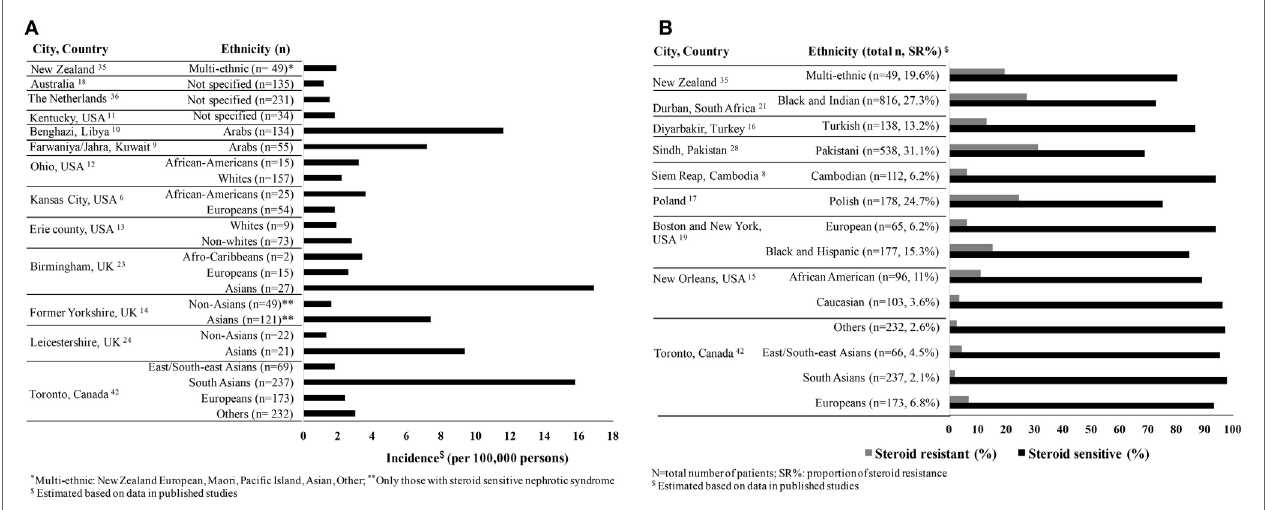
FiGURe 1 | (A) Incidence of childhood nephrotic syndrome per 100,000 persons by ethnicity reported from 1946 to 2014. (B) Variability of steroid responsiveness by ethnicity among children with nephrotic syndrome in reported studies from 1986 to